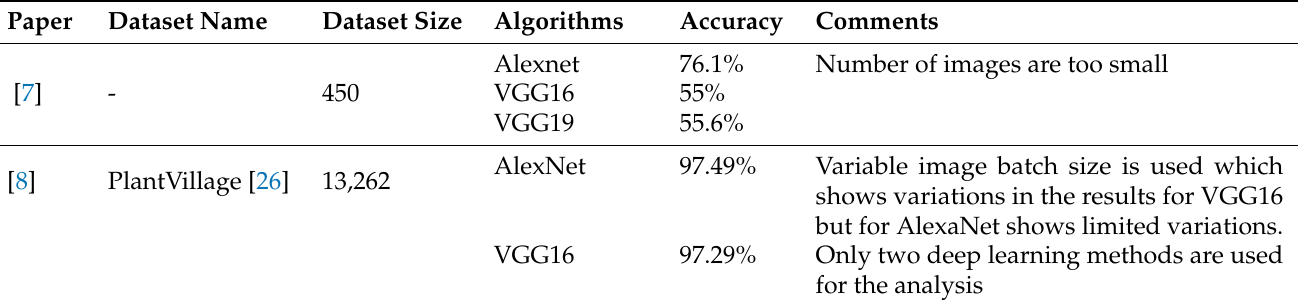
Table 1. Summary of related works on tomato leaf